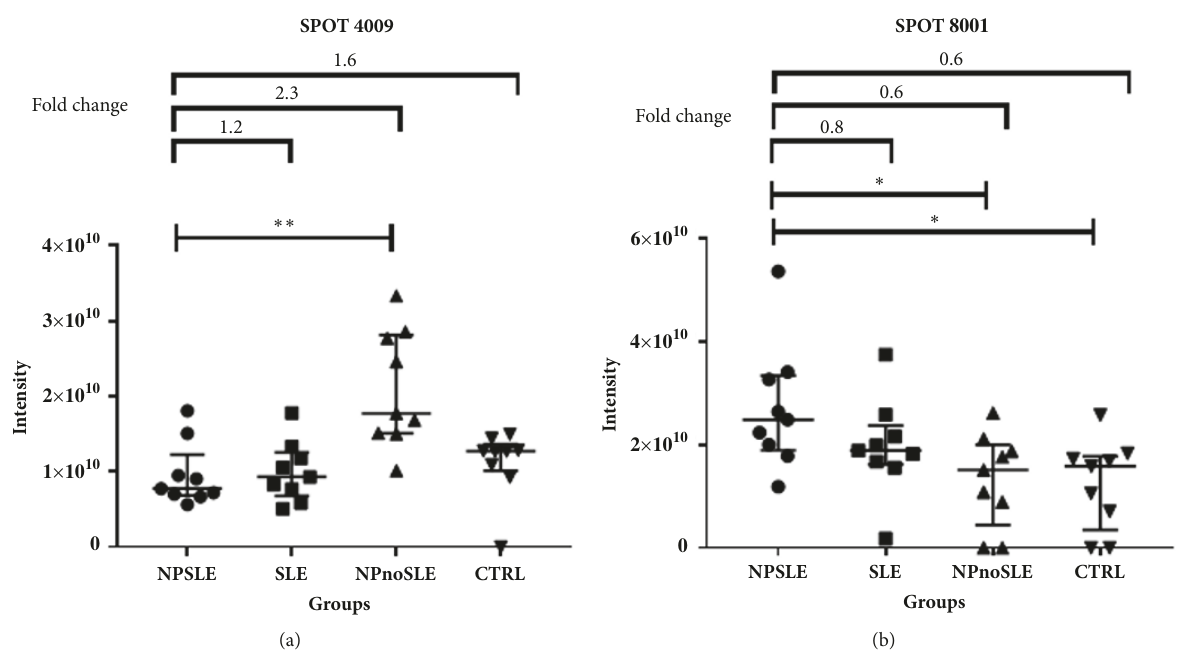
Figure 2: Intensity of spots 4009 (a) and 8001 (b) in NPSLE patients compared with SLE, NPnoSLE, and CTRL groups. The median and IQR of the intensities are shown for each group in both spots. These spots resulted differentially expressed in NPSLE with respect to NPnoSLE group in the case of spot 4009 (a) and also to the CTRL group for spot 8001 (b). The statistical analysis included the nonparametric Kruskal-Wallis test as well as Dunn’s test for the multiple comparisons. ∗ p ≤ 0,05 and ∗∗ p ≤ 0,01. The fold change values are shown in the upper side of the